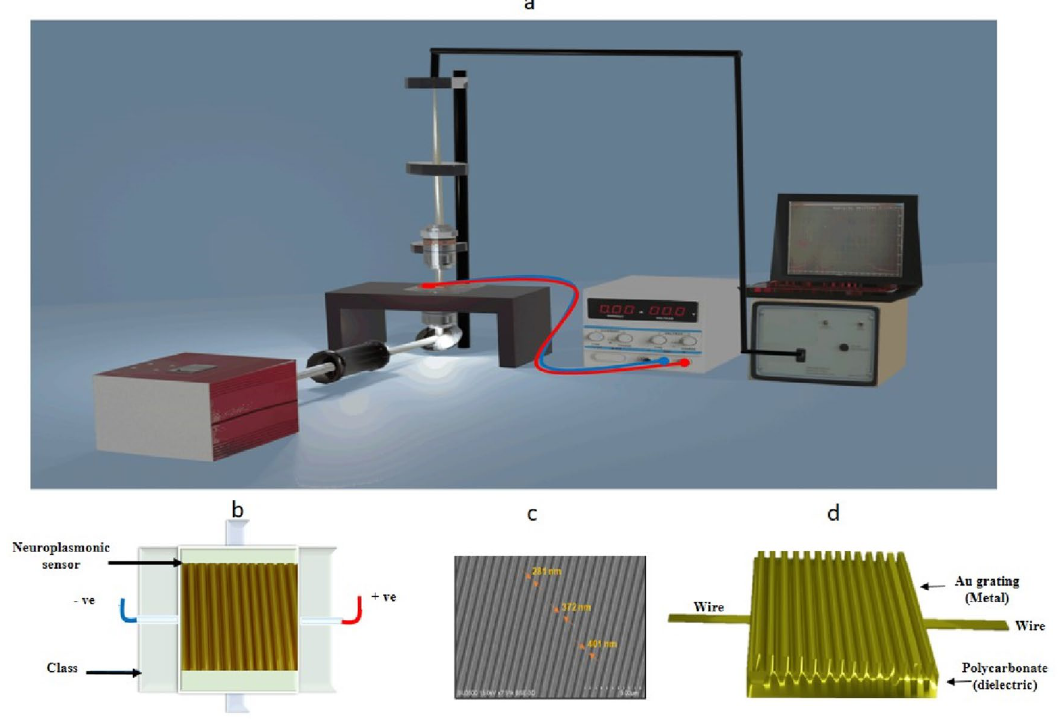
Figure 2. ( a ) The setup of our measurement system which contains the following parts: Light source broadband halogen illuminator (Thorlabs—OSL2), Collimator (Thorlabs—OSL2COL), Polarizer (Thorlabs—GT10-A), Optical lens (Thorlabs—AC254-035-A1), Reflected lens (Mirror), Numerical objective (NA = 0.65), XYZ Translation Stage (Thorlabs—PT3/M), Fiber Adapter Plate with C-Mount (Thorlabs—CMTSMA), Optical fiber (Ocean Optics—QP600-2-VIS–NIR), Spectrometer (Ocean Optics—Nanocalc-XR model), and DC power supply RXN − 303D ( b ) the homemade chamber including the plasmonics chip, ( c ) The scanning electron microscopy (SEM) image of the chip, and ( d ) The schematic of one-dimensional grating